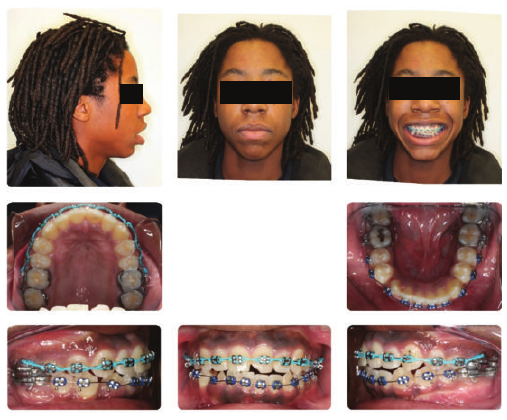
Figure 8: Progress